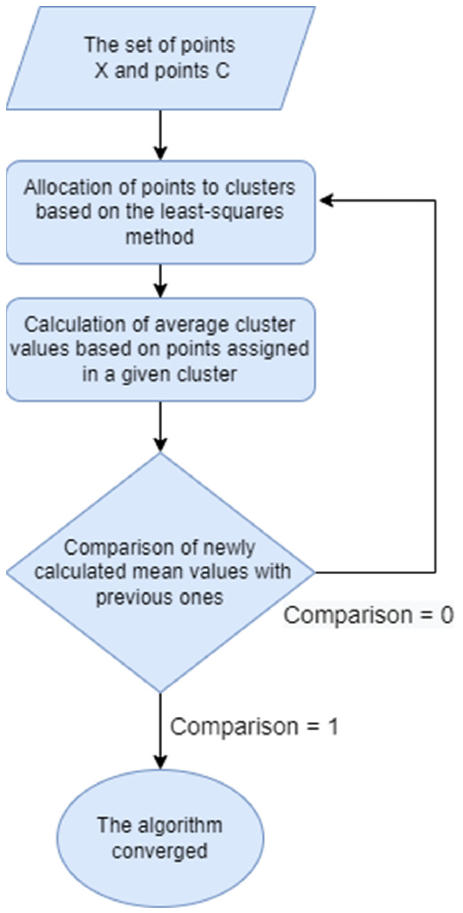
Figure 7. Principle of K-means algorithm functionality.